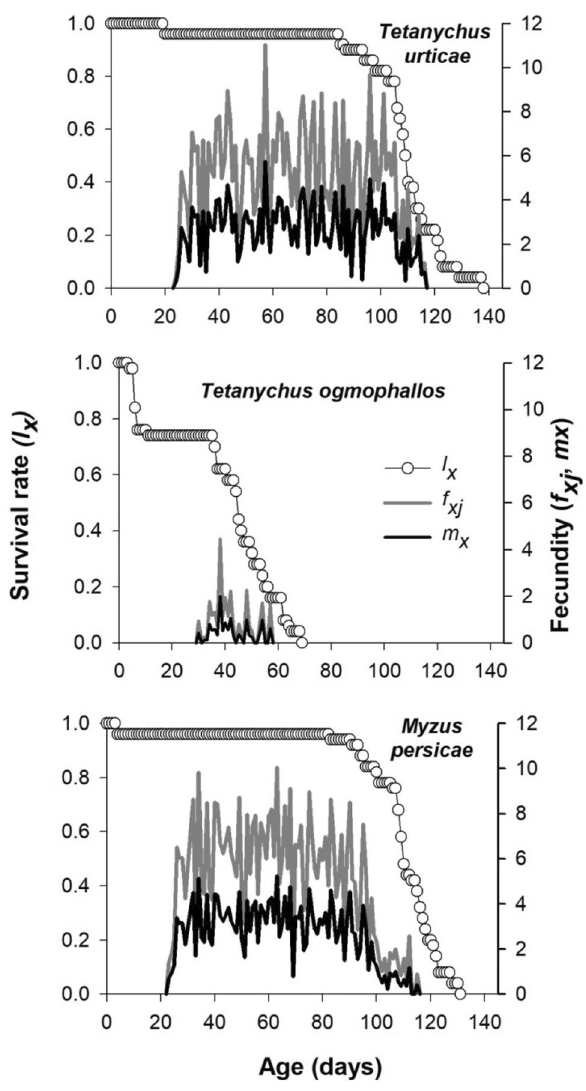
Figure 3. Age-specific survival rate ( l x ), age-specific fecundity ( m x ), and age-stage-specific fecundity ( f xj ) of Eriopis connexa fed on Tetranychus urticae , Tetranychus ogmophallos , or Myzus persicae